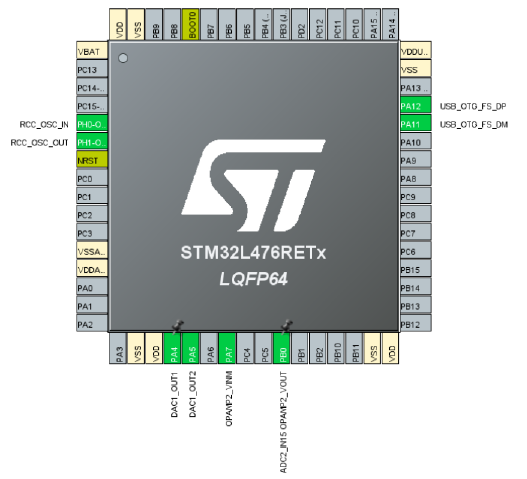
Figure 3: Pin configuration in